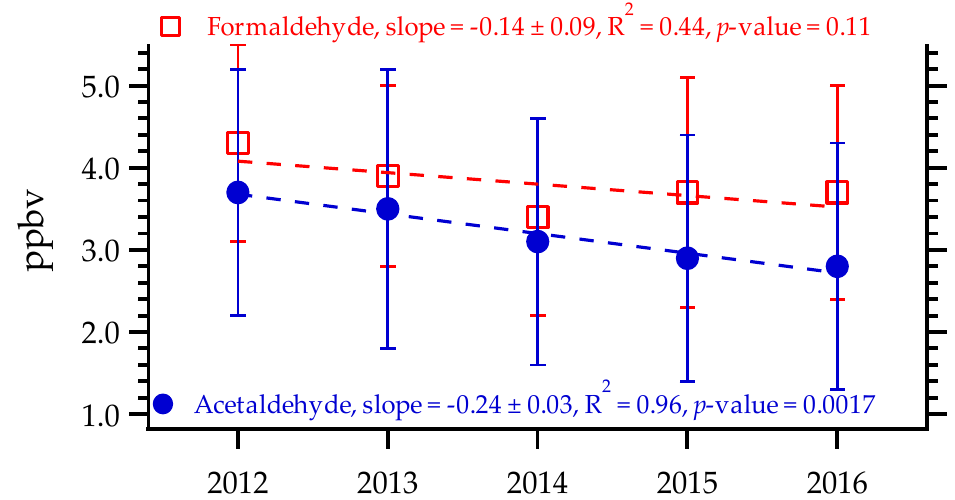
Figure 3. Annual trends in formaldehyde and acetaldehyde concentrations in the Metropolitan Area of São Paulo between 2012 and 2016. The dashed lines indicate the linear fit, and the bars indicate the standard deviation. Source: Pinheiros air quality monitoring station [24].